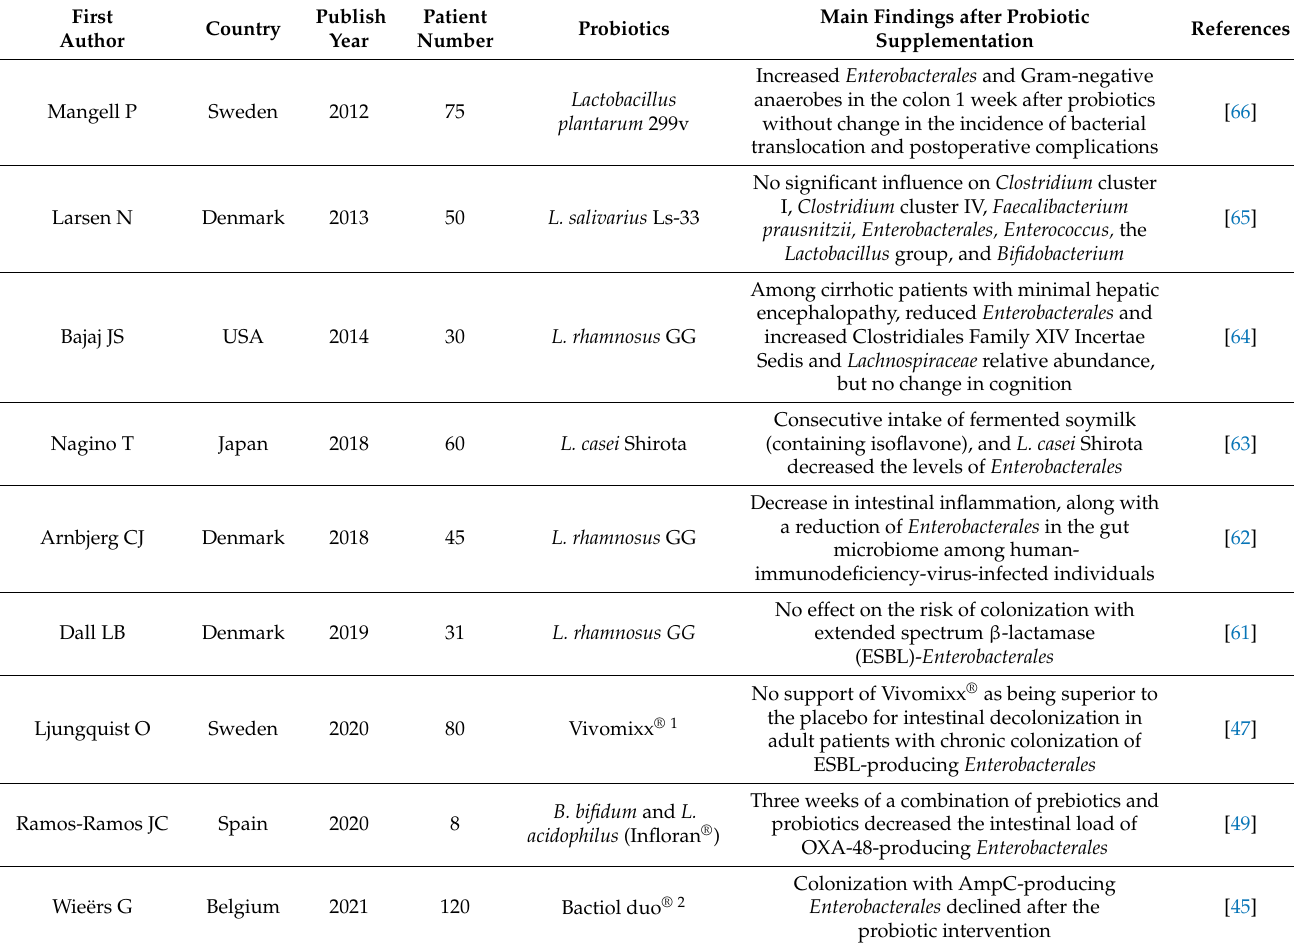
Table 2. Probiotic supplements for adults to decease potential pathogenic Enterobacterales in